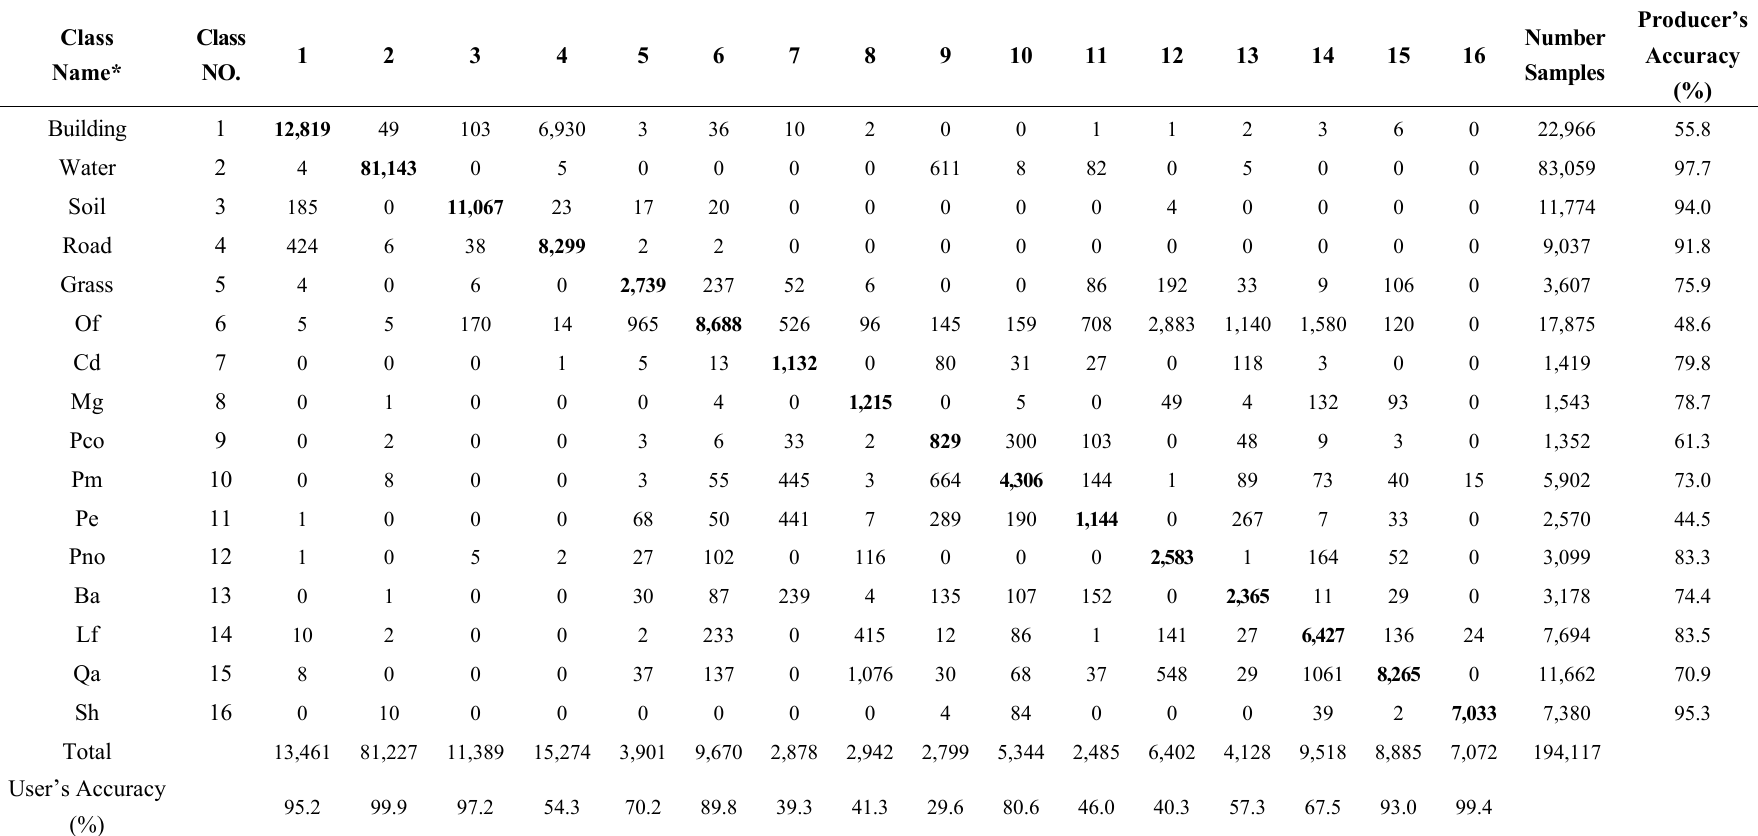
Table 2. Confusion matrix for the 16 classes using WorldView-2 imagery with eight bands by MultiSpec